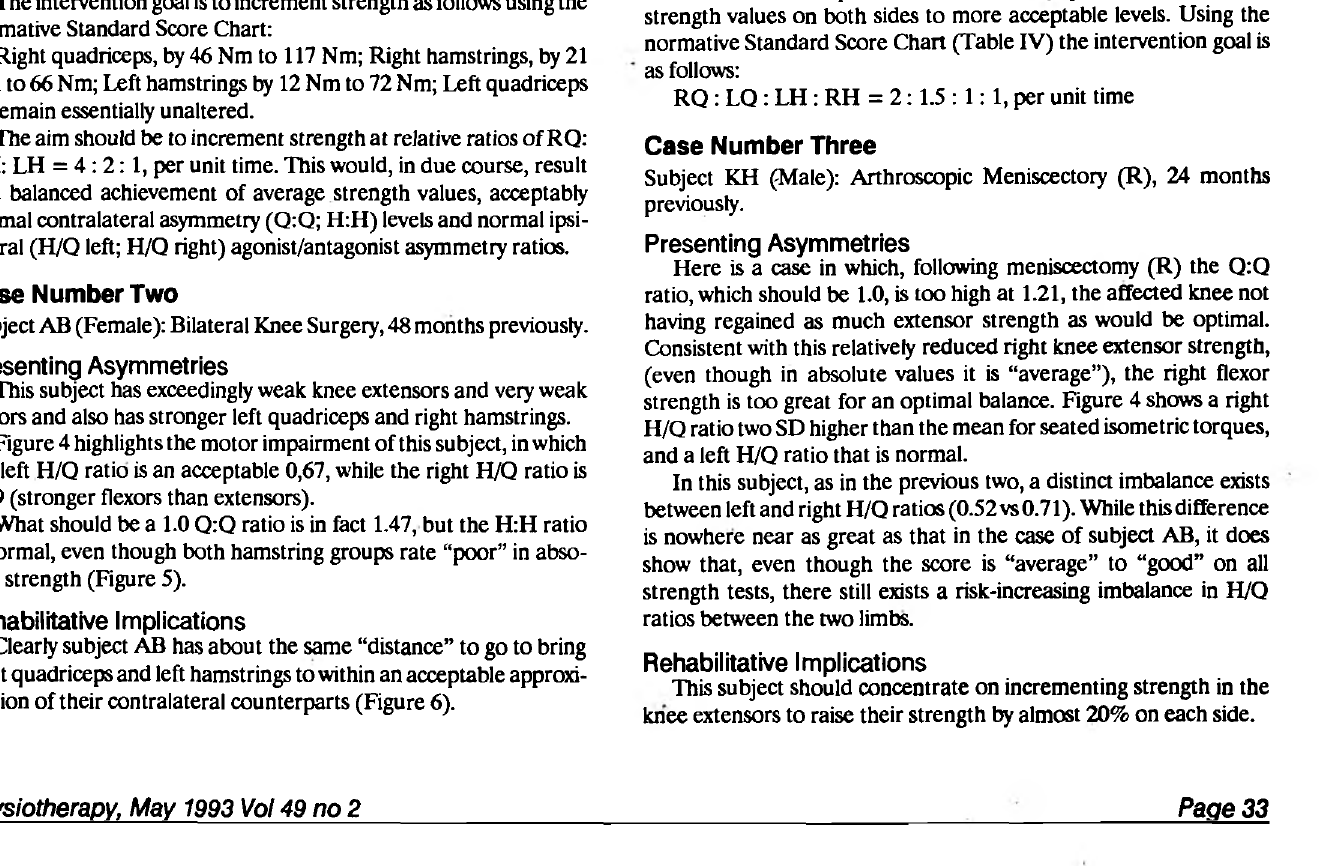
FIGURE 5: Clinically significant deviations in contralateral (Q/Q; H/H) ratios. FIGURE 6: Clinically significant defects of the weaker knee, in percent of the stronger in selected cases. Shaded bar depicts weaker quadriceps, in percent of stronger. Open bar depicts weaker hamstrings. Permissible deviations (le. normal asymmetry levels) are indicated by solid blocks on right. Width of gaps indicates extent of abnormal asymmetry. The rehabilita­ tive goal is to close these